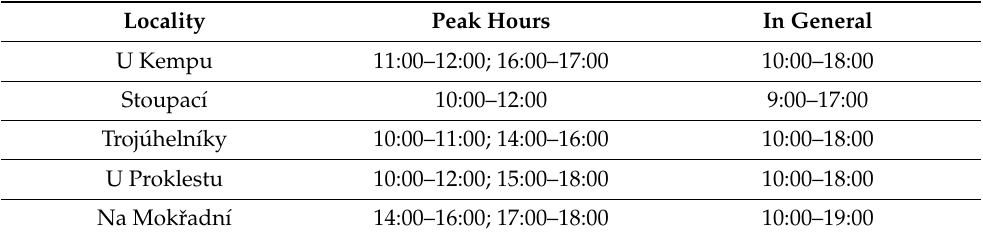
Table 3. Visitor layout by peak